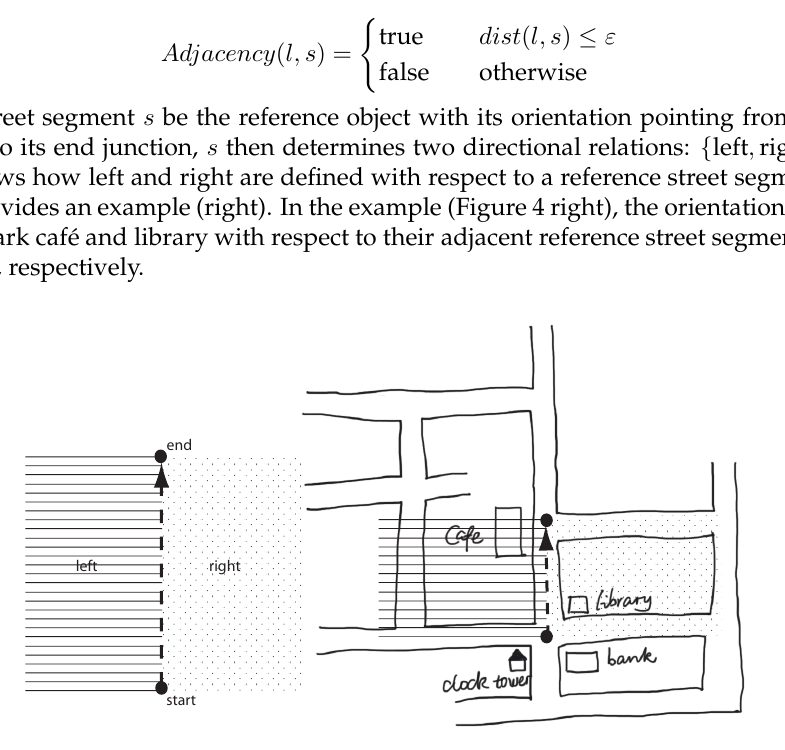
Figure 4: Definition (left) and an example of analyzing orientation of landmarks with re- spect to street segments